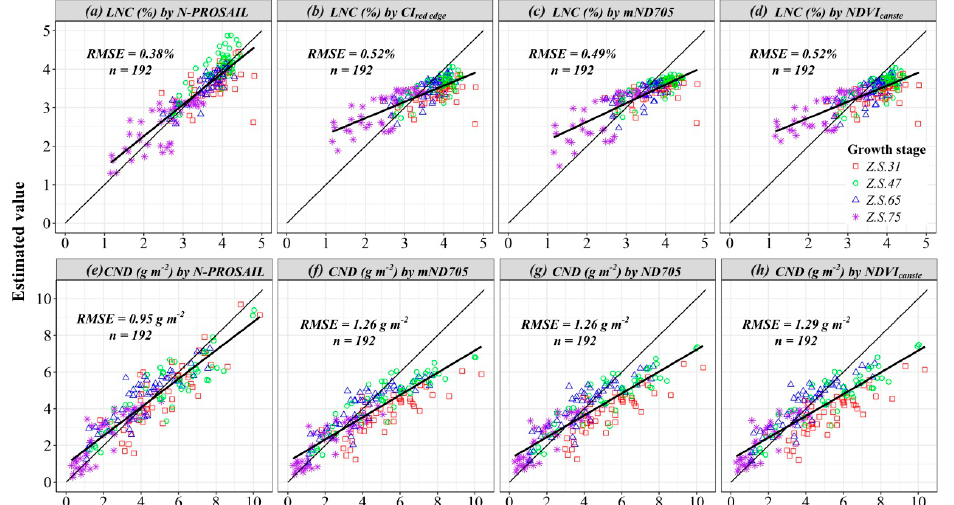
Figure 5. The relationships between measured and estimated values of LNC ( a – d ) and CND ( e – h ) in winter wheat by using data from 2014–2015 ( n = 192).